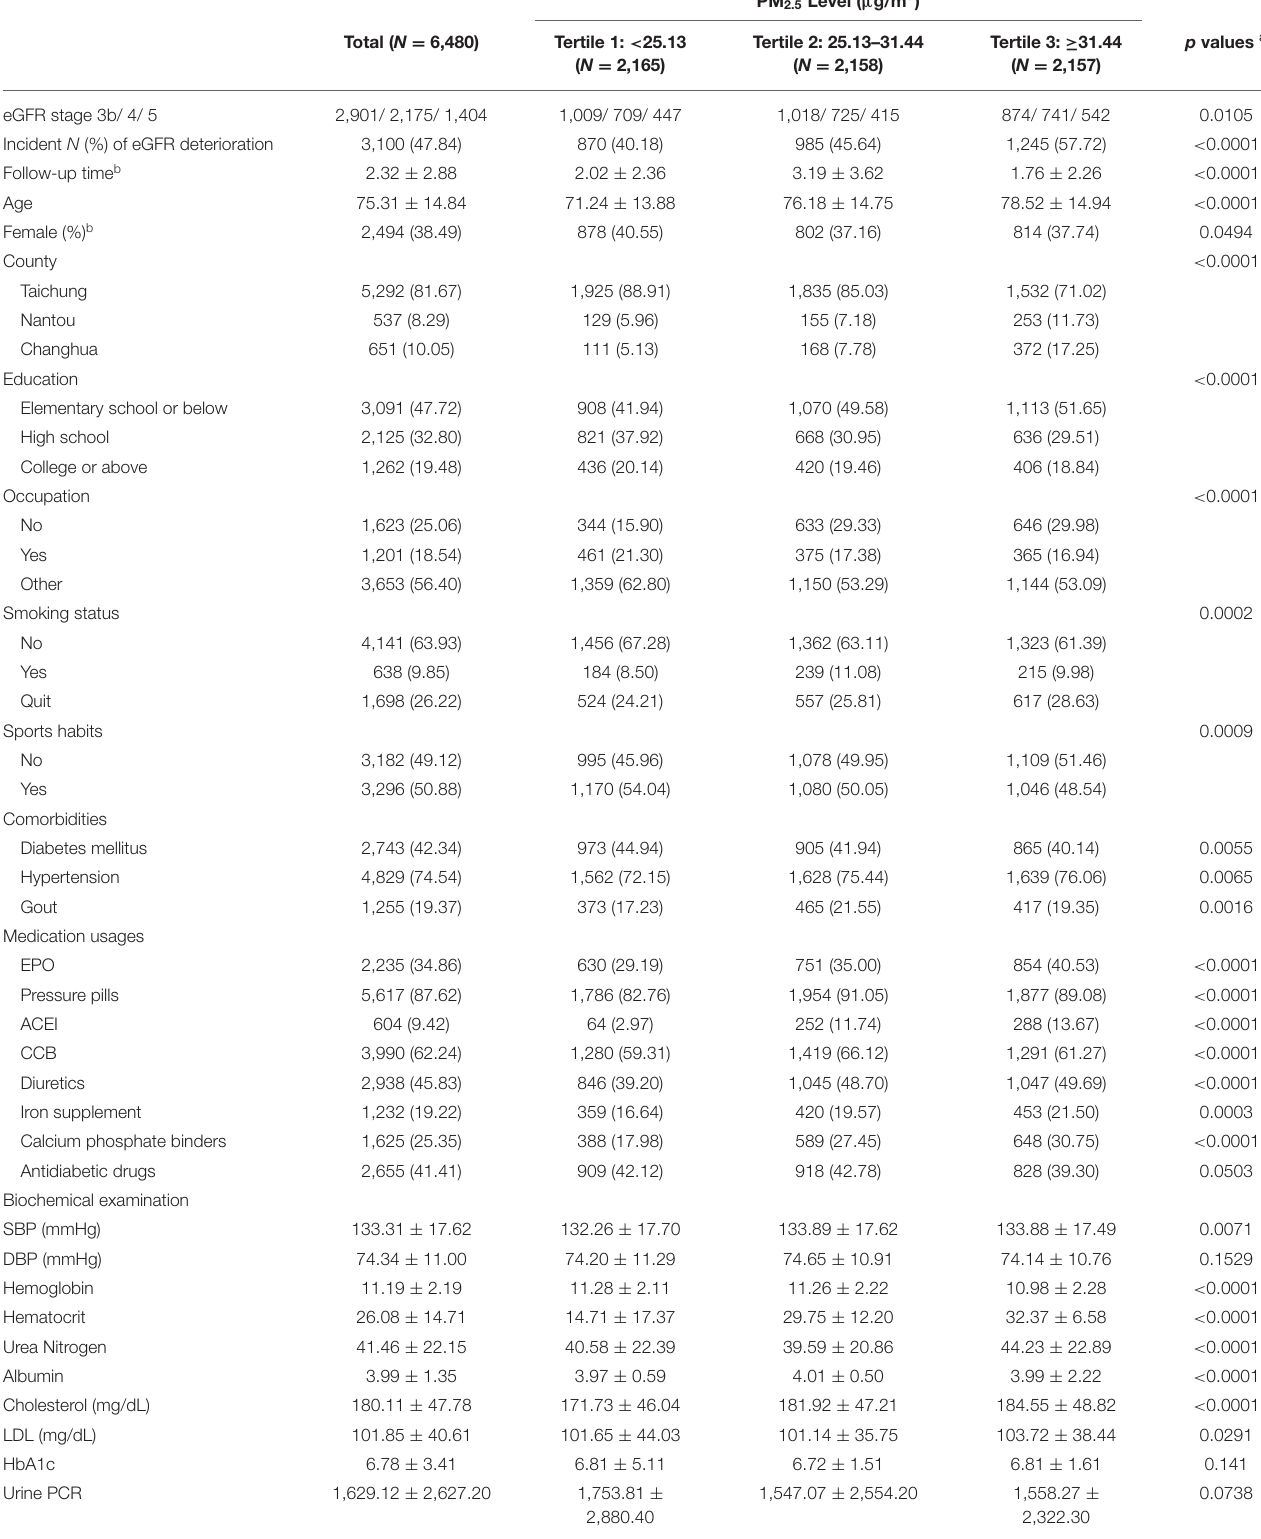
TABLE 1A | Demographic and health characteristics of overall study cohort and according to particles with diameter < 2.5 µ m (PM 2.5 )